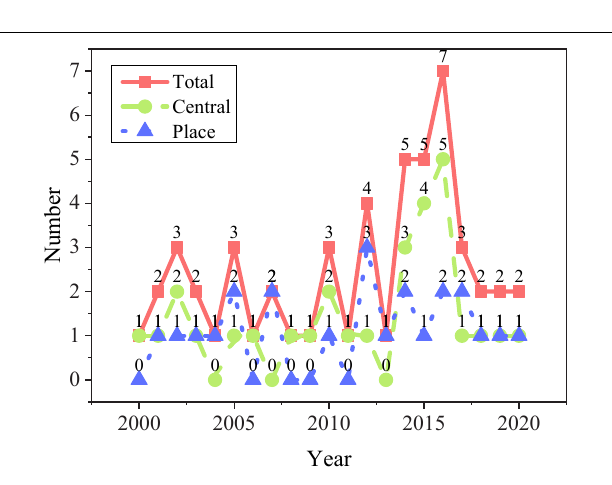
FIGURE 5 | Number of documents issued on education policys (EPs) for migrant children